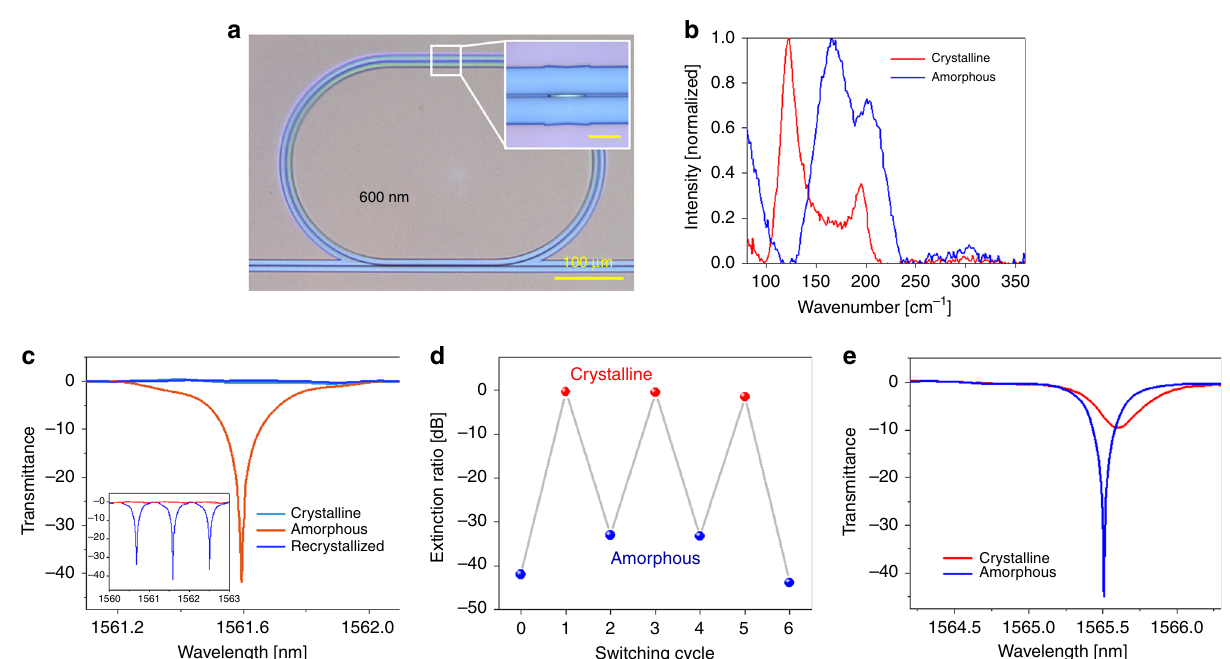
Fig. 6 Non-volatile integrated photonic switches based on optical phase change materials (O-PCMs). a Optical micrograph of the resonant switch: inset shows the Ge 2 Sb 2 Se 4 Te 1 (GSS4T1) strip on top of the SiN waveguide. b Raman spectra of laser switched GSS4T1, where the peaks at 160 and 120 cm − 1 are signatures of the amorphous and crystalline states, respectively. c Normalized transmittance spectra of the resonant switch integrated with GSS4T1, showing complete on/off modulation of the resonant peaks. Inset displays the broadband transmittance spectra of the same device. The three spectra correspond to three states of GSS4T1: (orange) as-deposited amorphous, (light blue) crystallized through furnace annealing, and (blue) laser recrystallized. d Resonance extinction ratio modulation of the device upon laser switching. e Normalized transmittance spectra of a reference switch device integrated with Ge 2 Sb 2 Te power MOSFET connected in series to the device. Figure 7b shows the SEM image of a full device with the contact pads and Fig. 7c shows the zoom-in on the GSS4T1 patterned pixel. To